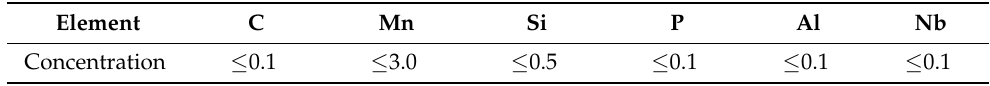
Table 1. Automotive steel (SPFH590) chemical composition (in weight%).